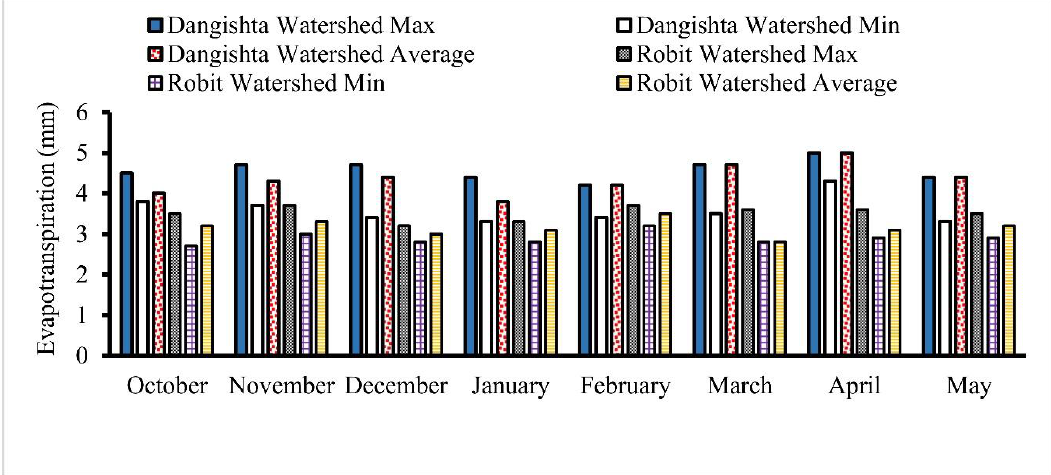
Figure 7. Maximum, minimum, and average reference evapotranspiration ( ET o ) in mm/day for Dangishta and Robit watersheds.